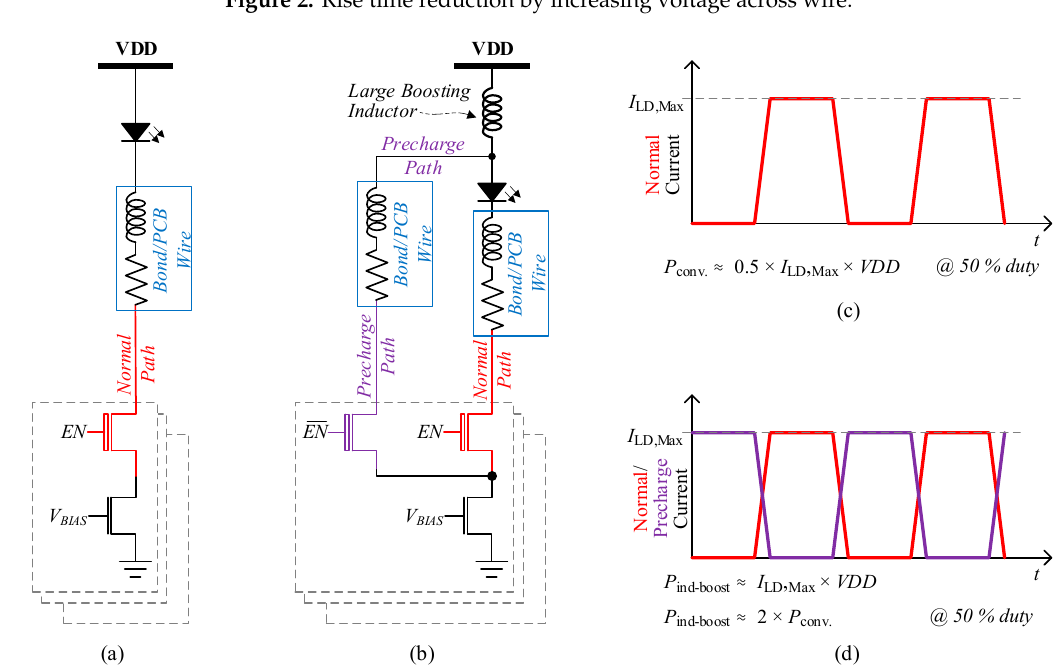
Figure 3. ( a ) Conventional driver with VCSEL. ( b ) Simplistic inductor boosting-based driver with VCSEL. ( c ) Conventional driver current waveform. ( d ) Inductor boosting based driver current